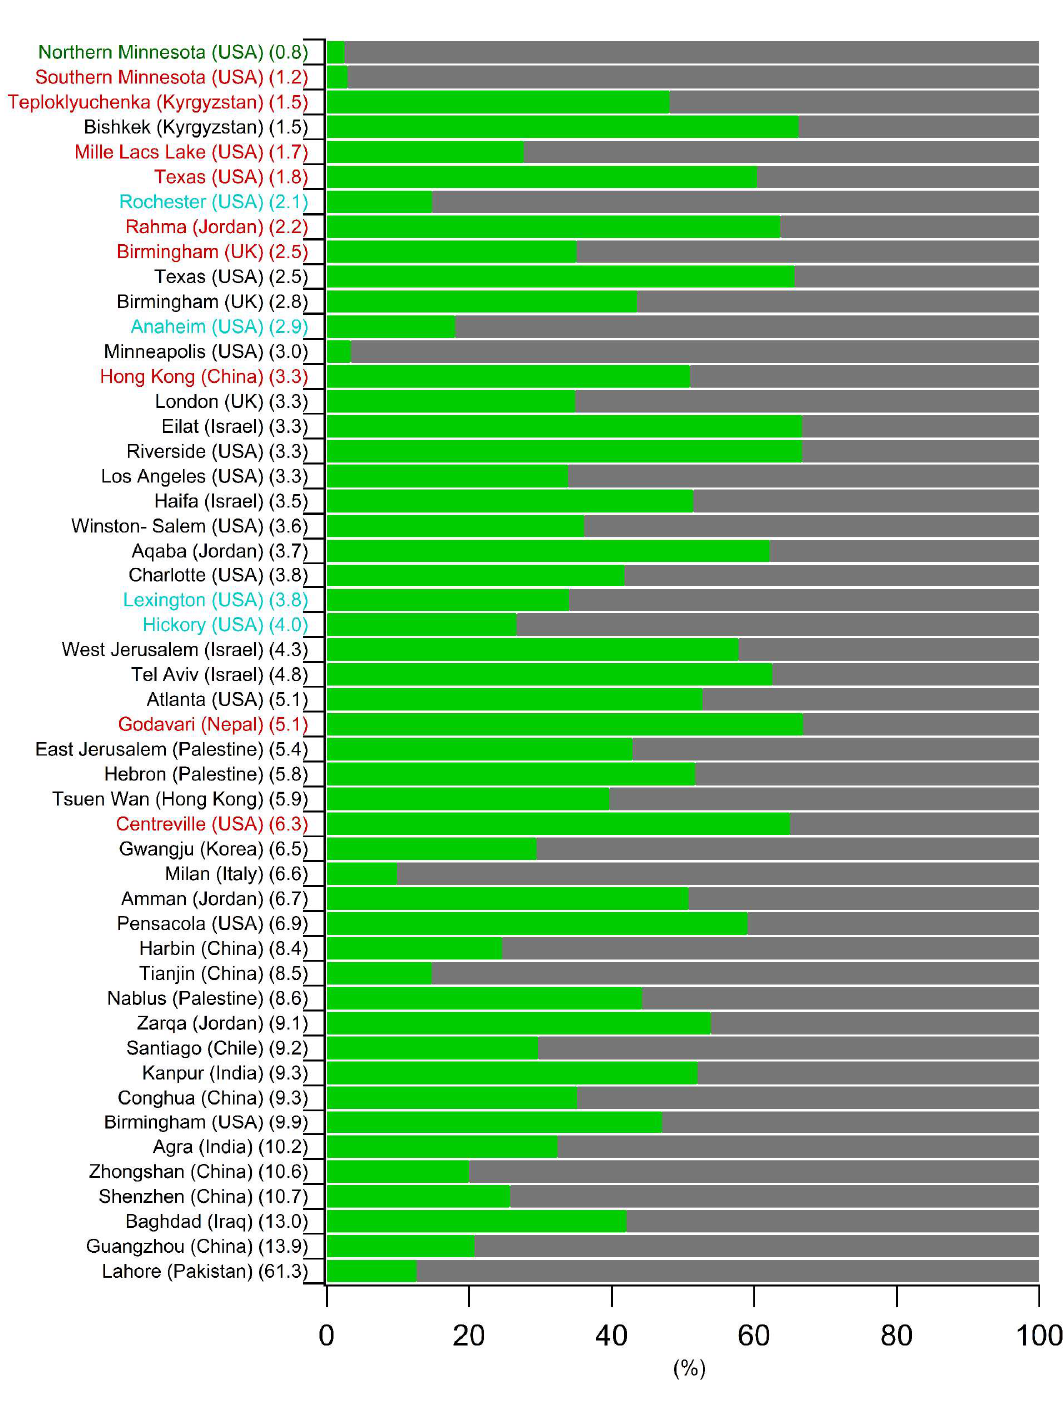
Figure 4. Annual SOC (green) and POC (grey) contributions to PM 2.5 OC using chemical mass balance (CMB) for all the monitored sites from 2006 to 2016. Results are presented in increasing order of OC concentration levels ( µ gC m − 3 ). In black, urban sites; in blue, suburban sites; in red, rural sites and in green, remote